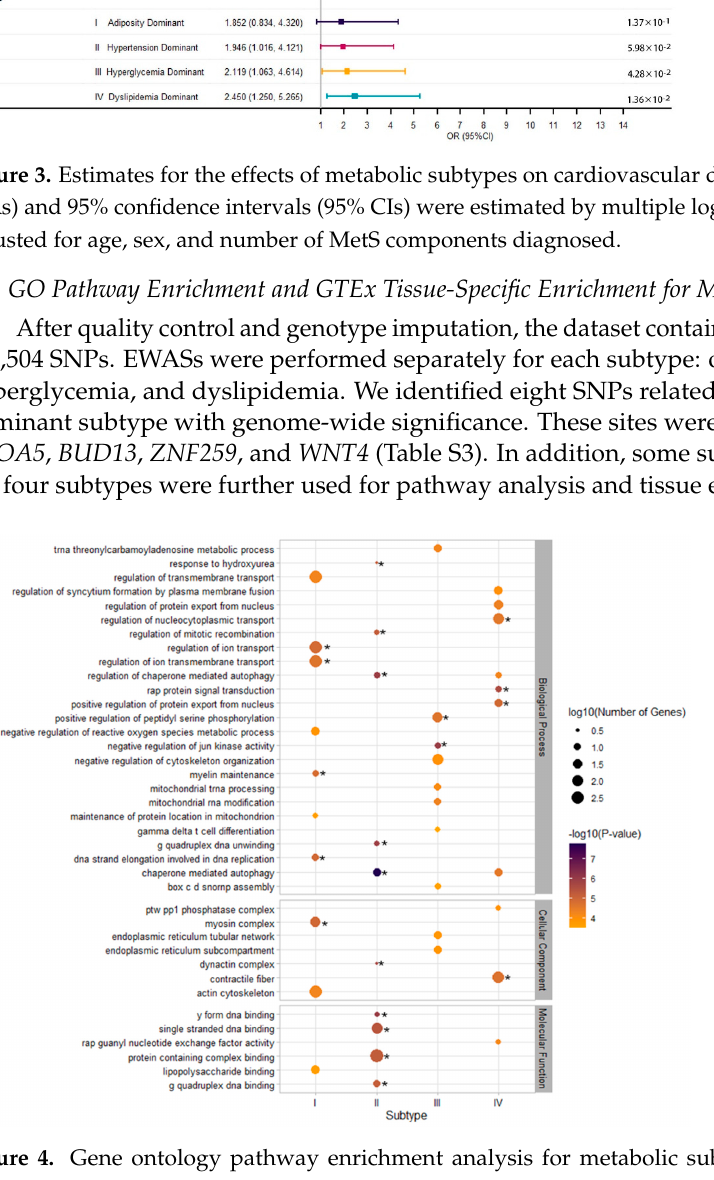
Figure 2. Quantitative and binary distributions for characteristics of different subtypes *. * Contin- uous variables are shown as means and standard deviations after being standardized to a unified scale. BMI, body mass index; Waist, waist circumference; SBP, systolic blood pressure; DBP, dias- tolic blood pressure; FBG, fasting blood glucose; 2h-PBG, 2 h postprandial blood glucose; TC, total cholesterol; TG, triglyceride; LDL-C, low-density lipoprotein cholesterol; HDL-C, high-density lipoprotein cholesterol; HBP, hypertension; DM, type 2 diabetes; HLP, hyperlipidemia; CHD, cor- onary heart disease; MetS, metabolic syndrome.